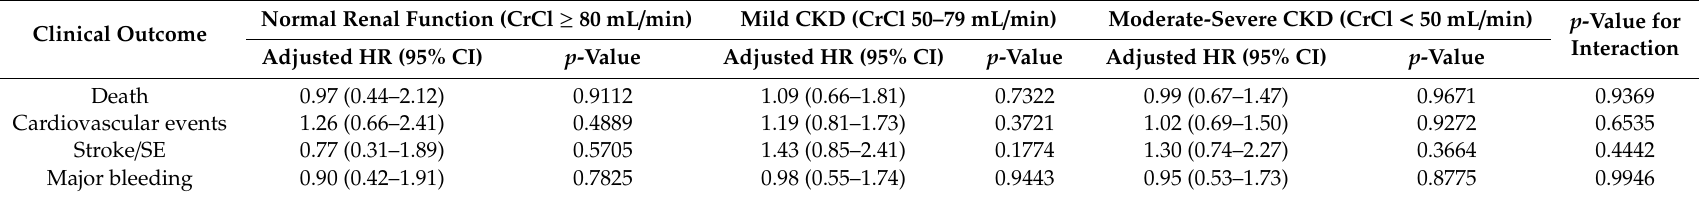
Table 3. Adjusted hazard ratio of the adverse clinical events of DOACs (versus warfarin) stratified by the renal